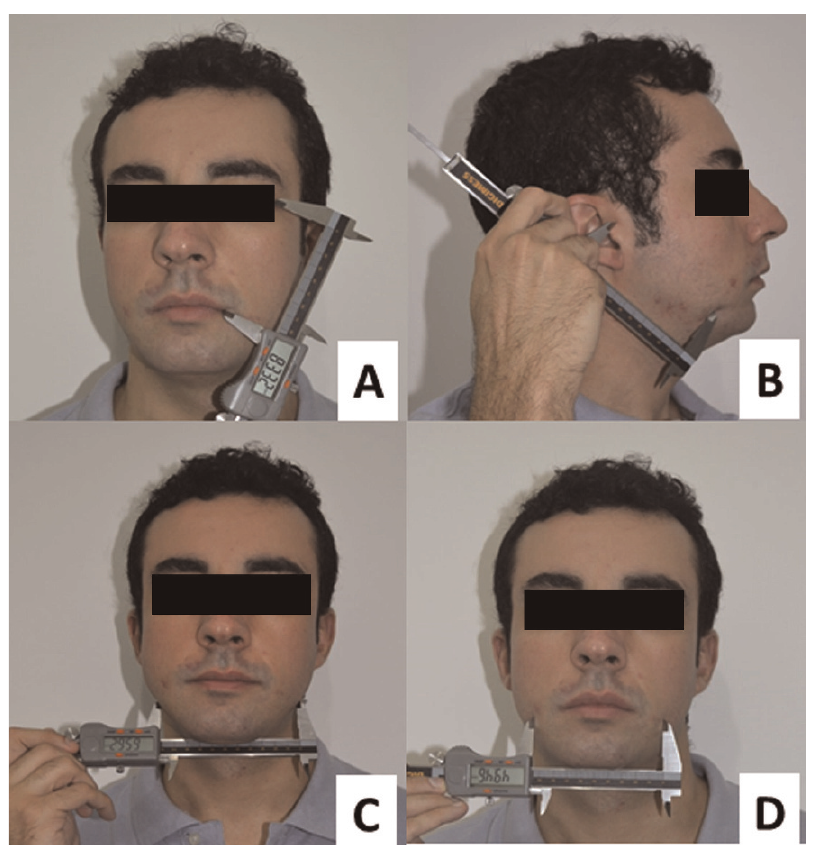
Figure 3 - Anthropometric measures: A=medial portion of the face; B=lateral portion of the face;